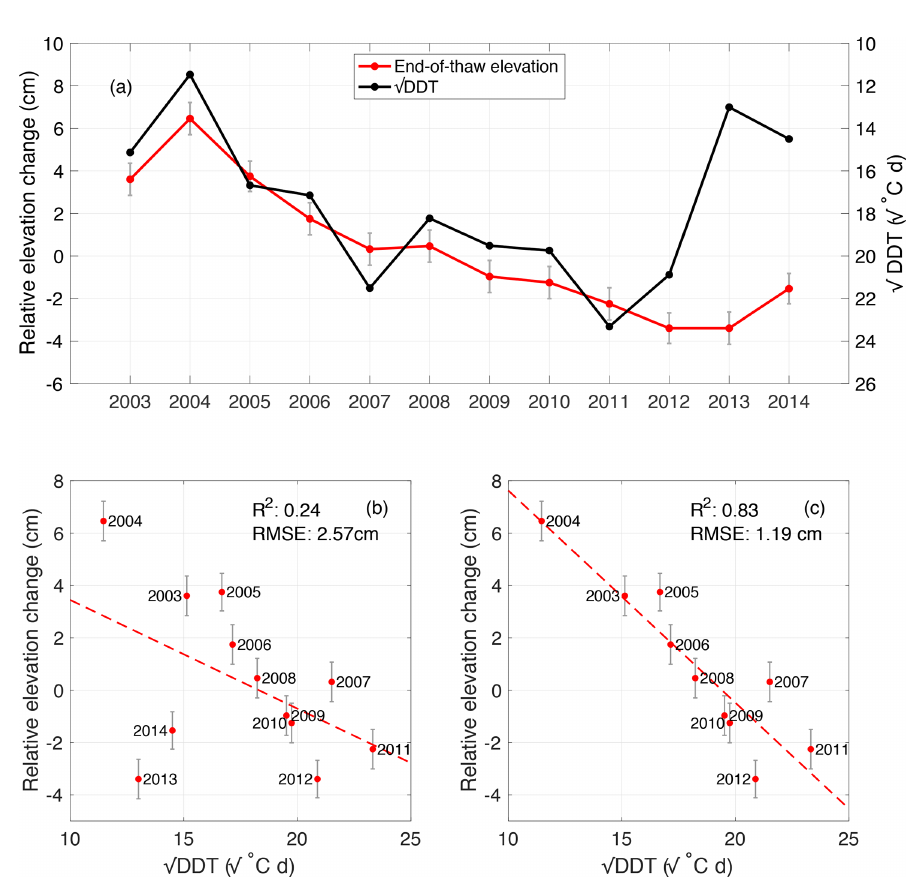
√ DDT during 2003–2014. The right vertical axis for √ DDT and the end-of-thaw elevations. (b) Scatter plot of the end-of-thaw elevations versus